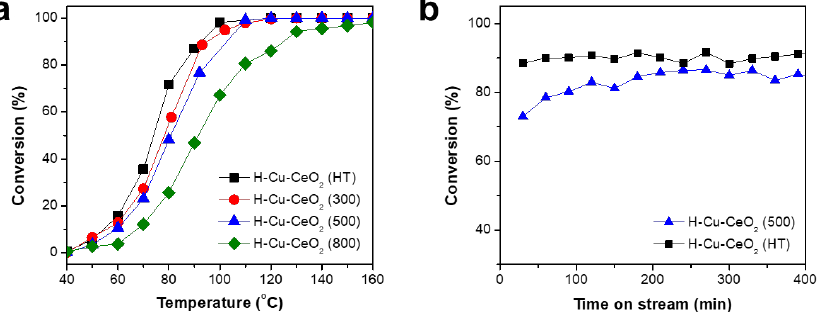
Figure 6. ( a ) CO conversion change as reaction temperature increases and ( b ) time-on-stream test results of the H-Cu-CeO 2 catalysts.